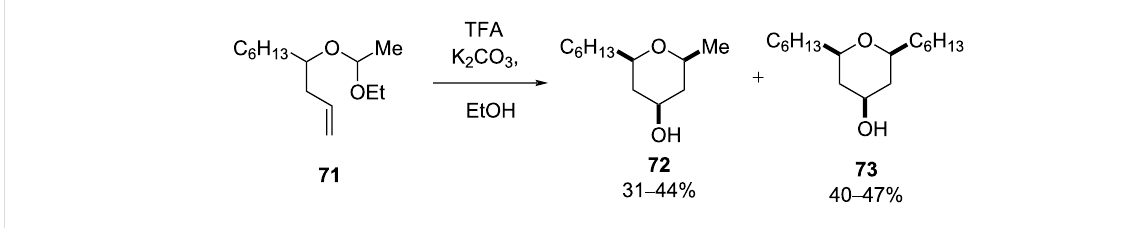
Scheme 15: Hart and Bennet's acid-promoted Prins cyclization.